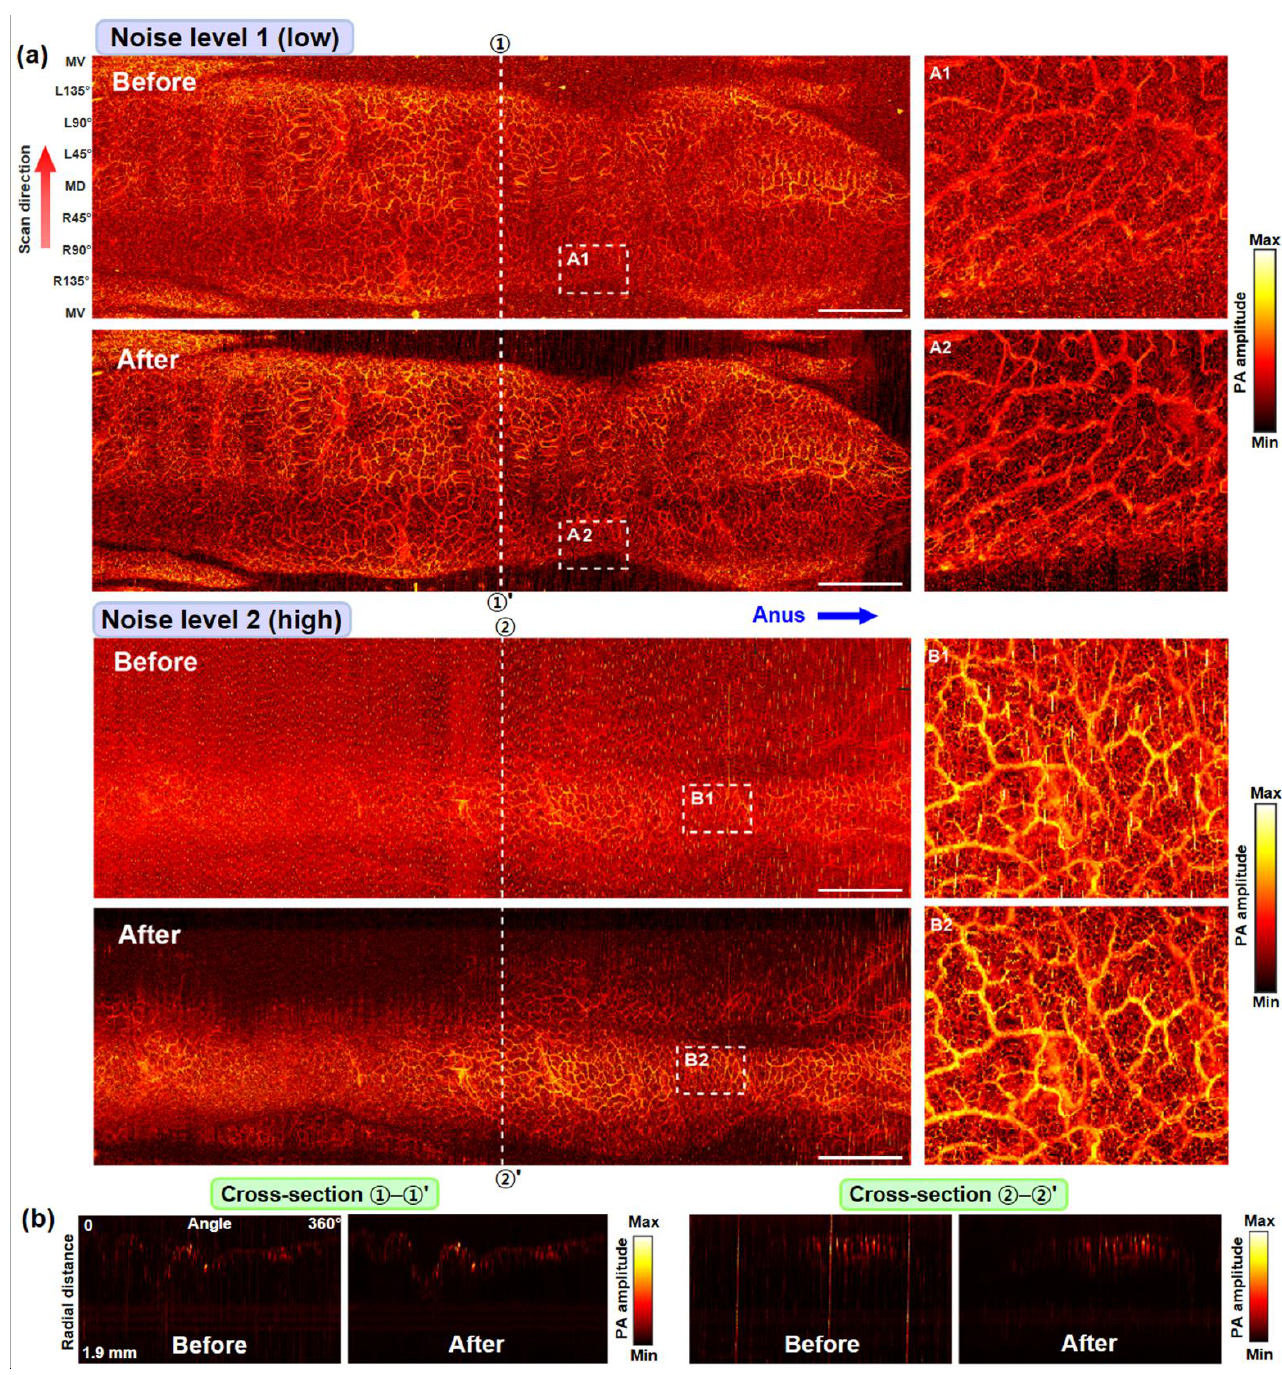
Figure 5. Performance test results for two in vivo rat colorectum test datasets with different EMI noise levels: ( a ) whole PA-RMAP images (left) and magnified images for the dashed box regions (right). MD, mid-dorsal; MV, mid-ventral; L, left; R, right. Scale bars, 5 mm (horizontal only). ( b ) B-scan (or cross-sectional) images for the marked positions in ( a ).